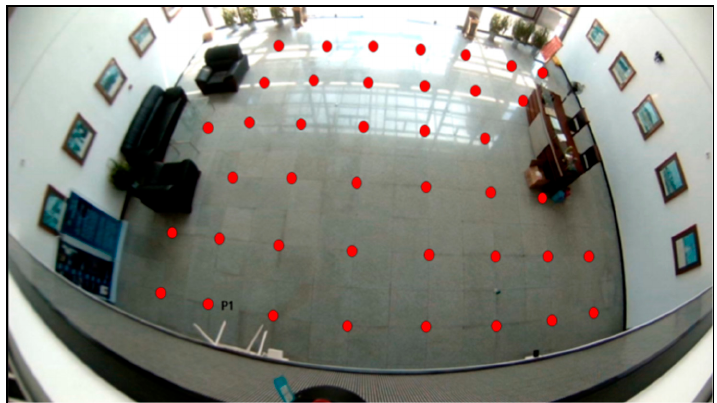
Figure 11. Test-points and camera deployment.